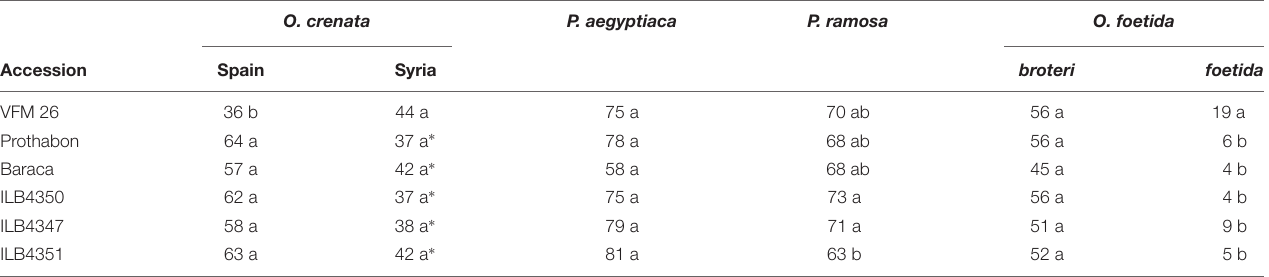
TABLE 2 | Percentage of broomrape seeds germination on the vicinity of faba bean accessions.